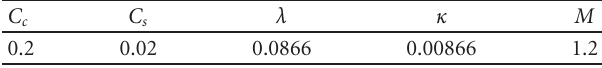
Figure 7: Vertical movement around the tunnel using MCC model for the first layer. Table 2: Cam clay parameters for Baghdad silty clay